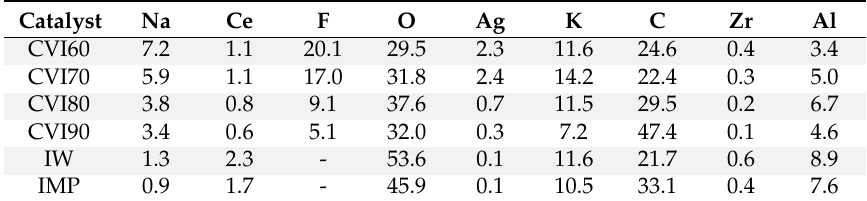
Table 2. Atomic % of elements for each catalyst from XPS